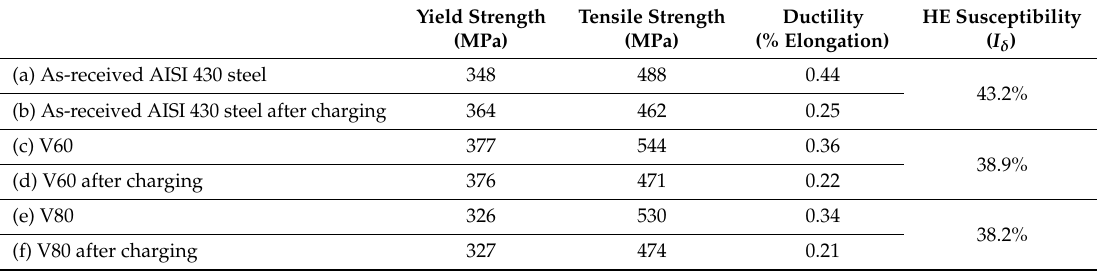
Figure 5. Stress-strain curves of ( a ) as-received AISI 430 steel, ( b ) hydrogen-charged AISI 430 steel for 1 week, ( c ) V60, ( d ) V60 hydrogen-charged for 1 week, ( e ) V80, ( f ) V80 hydrogen-charged for 1 week. Table 4. Mechanical parameters of various specimens.